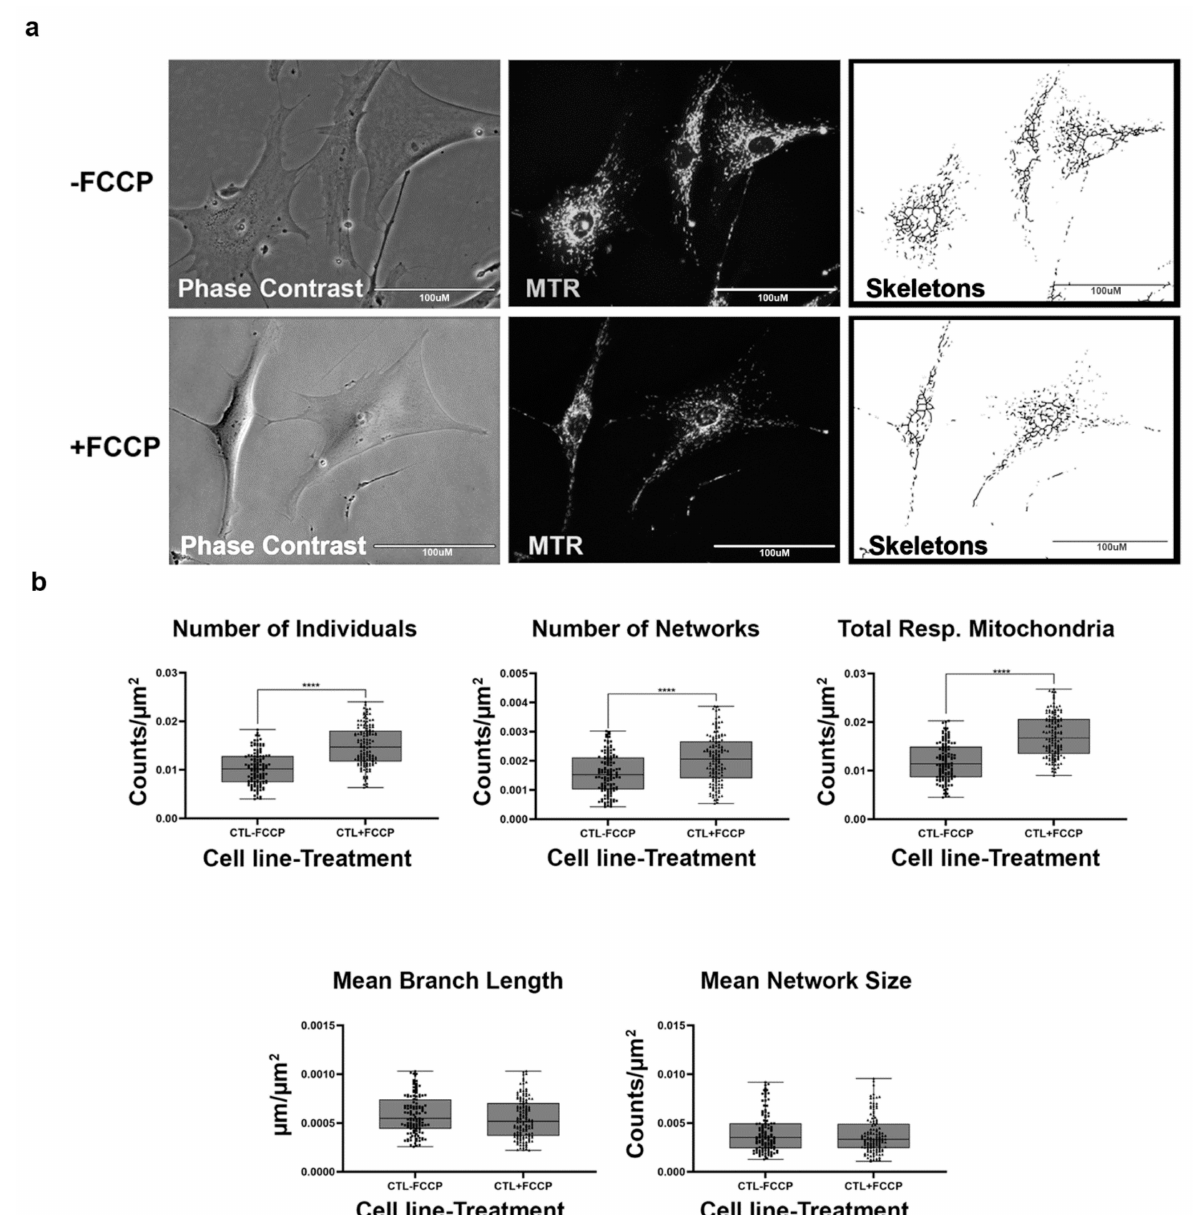
Figure 2. Mitochondrial morphology of healthy BJ fibroblast in the absence and presence of FCCP. ( a ) Representative images of fibroblast cell lines stained with Mitotracker Red CM-H2Xros (MTR), a dye that localizes to actively respiring mitochondria. The top images are phase contrast, RFP, and skeletonized images of healthy control cell lines without FCCP treatment. The bottom images are phase contrast, RFP, and skeletonized images of healthy control cell lines with FCCP treatment. ( b ) MiNA descriptors showing differences in mitochondrial morphology in untreated and FCCP treated groups. FCCP treatment resulted in mitochondrial fission and resulted in a significant increase in the number of individuals, networks, and total respiring mitochondria. The mean branch length and mean network size are lower after FCCP treatment, albeit not statistically significant. All data are representative of 10–14 images taken from five independent dishes per treatment group. The bars represent minimum and maximal values, and each black dot represents different data points. **** p < 0.0001. Scale bar = 100 µ